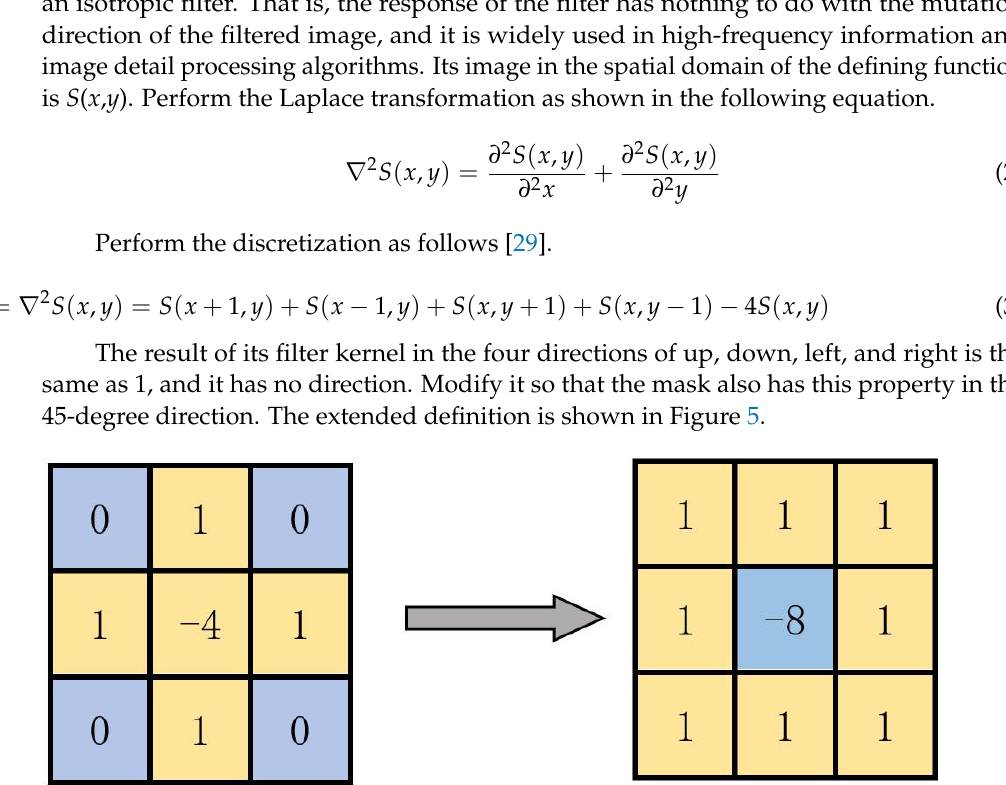
Figure 4. Surface inspection plan layout.